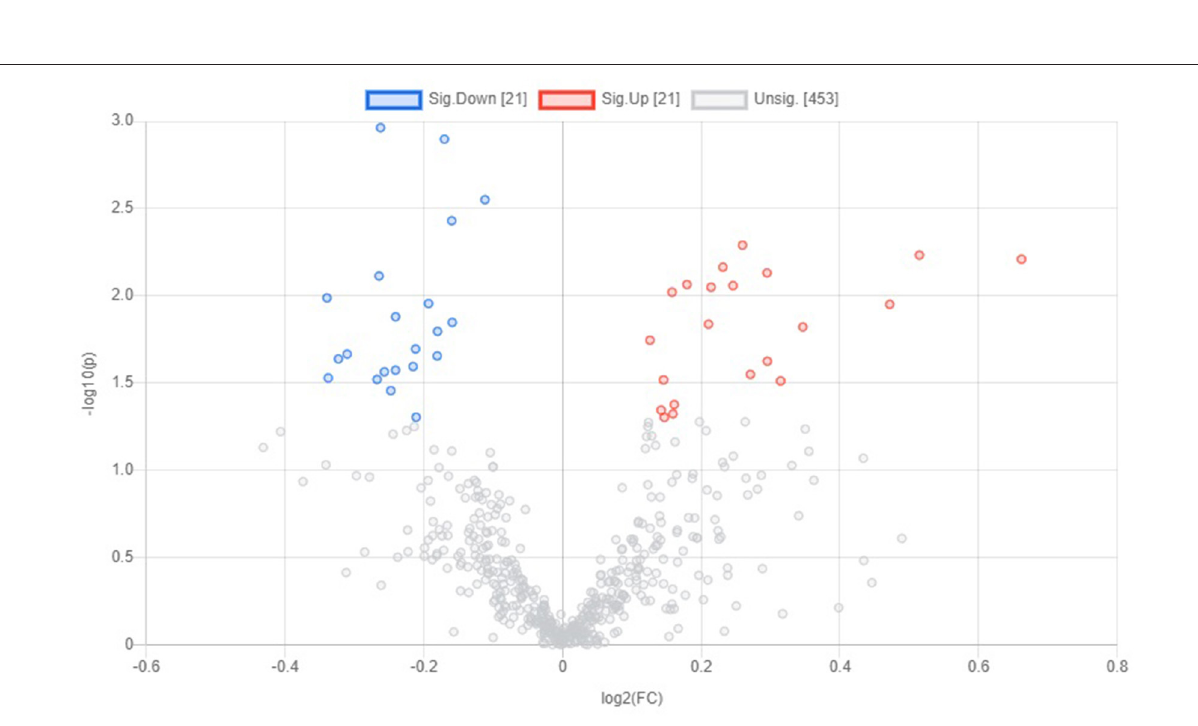
Frontiers in Animal Science |